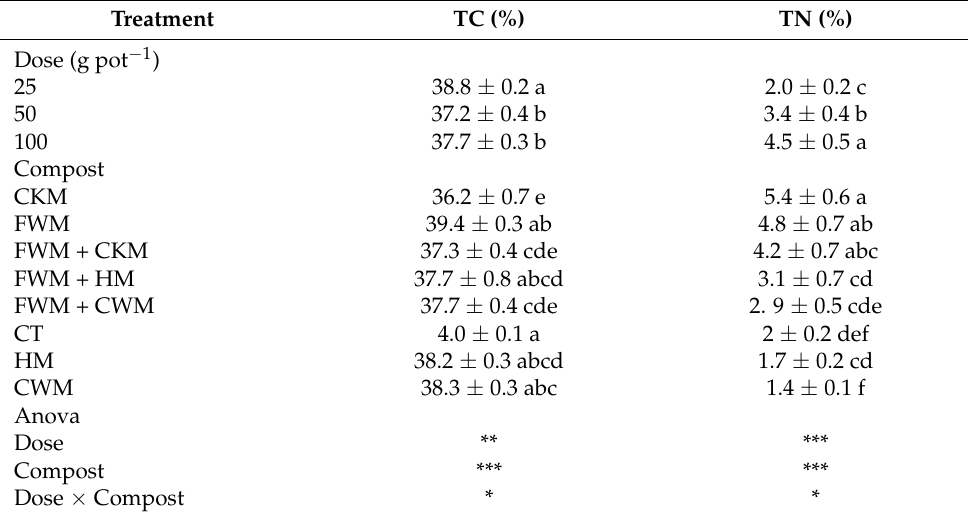
Table 4. Total carbon (TC) and total nitrogen (TN) ratios of komatsuna under different doses and